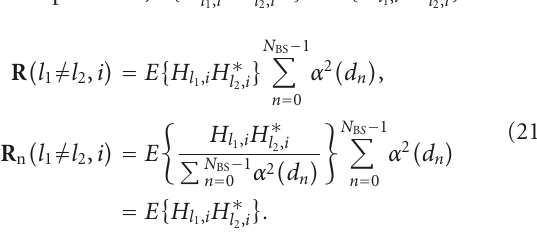
Figure 8: Correlation characteristics over the subcarriers for d 0 = [334 m,335m,336 m].